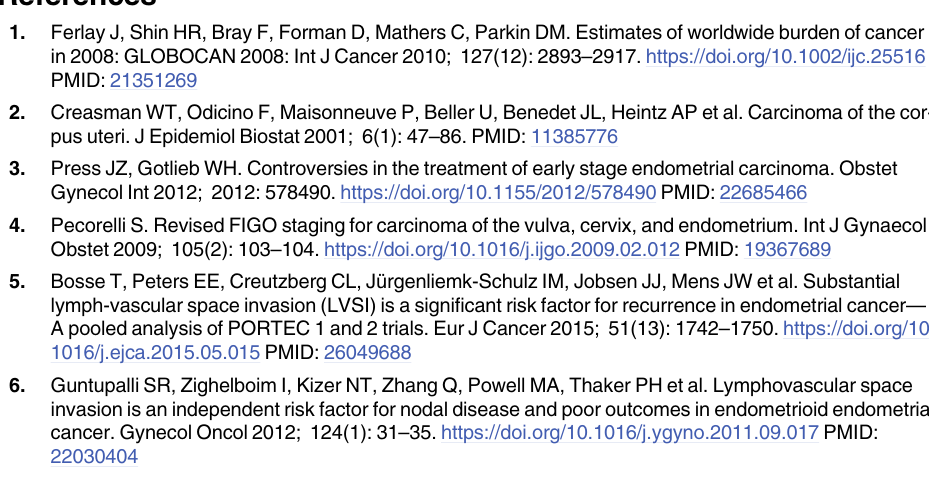
S1 Fig. Overall survival curves for patients with and without